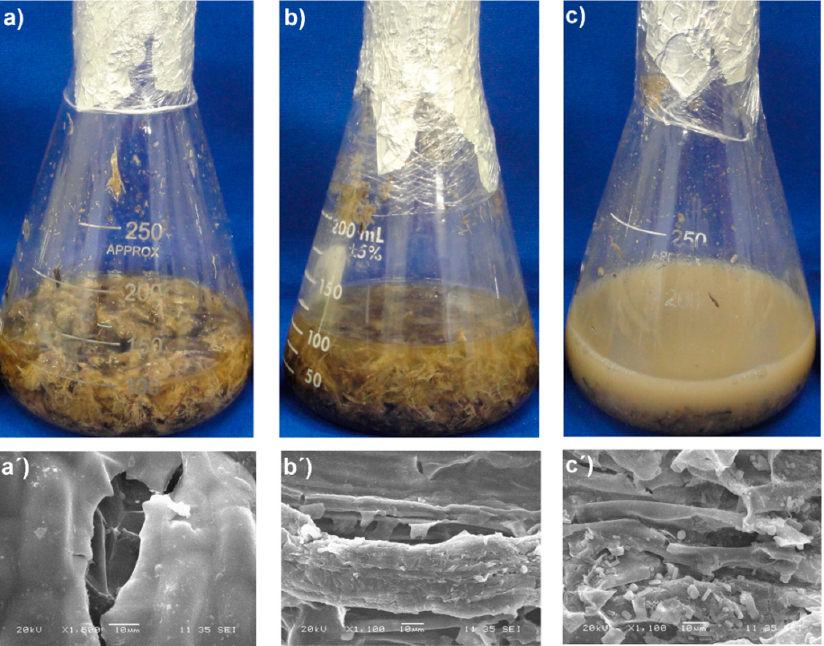
Figure 2. Scanning electron micrographs of macroalgae consortium samples before and after pretreatment. ( a , a´ ): macroalgae consortium (Mc), ( b , b´ ): macroalgae + fungal broth (McFb), ( c , c´ ): macroalgae + fungi (McF). ( c , c´ ): macroalgae + fungi